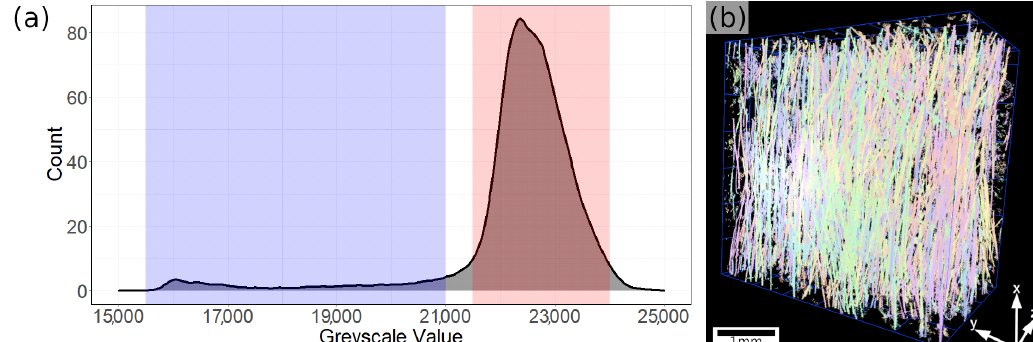
Figure 2. ( a ) Histogram of the objects segmented from the LHE image projected back to the original scan. The separation into discrete peaks highlighted in blue and red allows differentiating between noise and fibers. ( b ) 3-dimensional image of the final segmentation after refinement based on fiber geometry. This segmentation is used for alignment analysis.